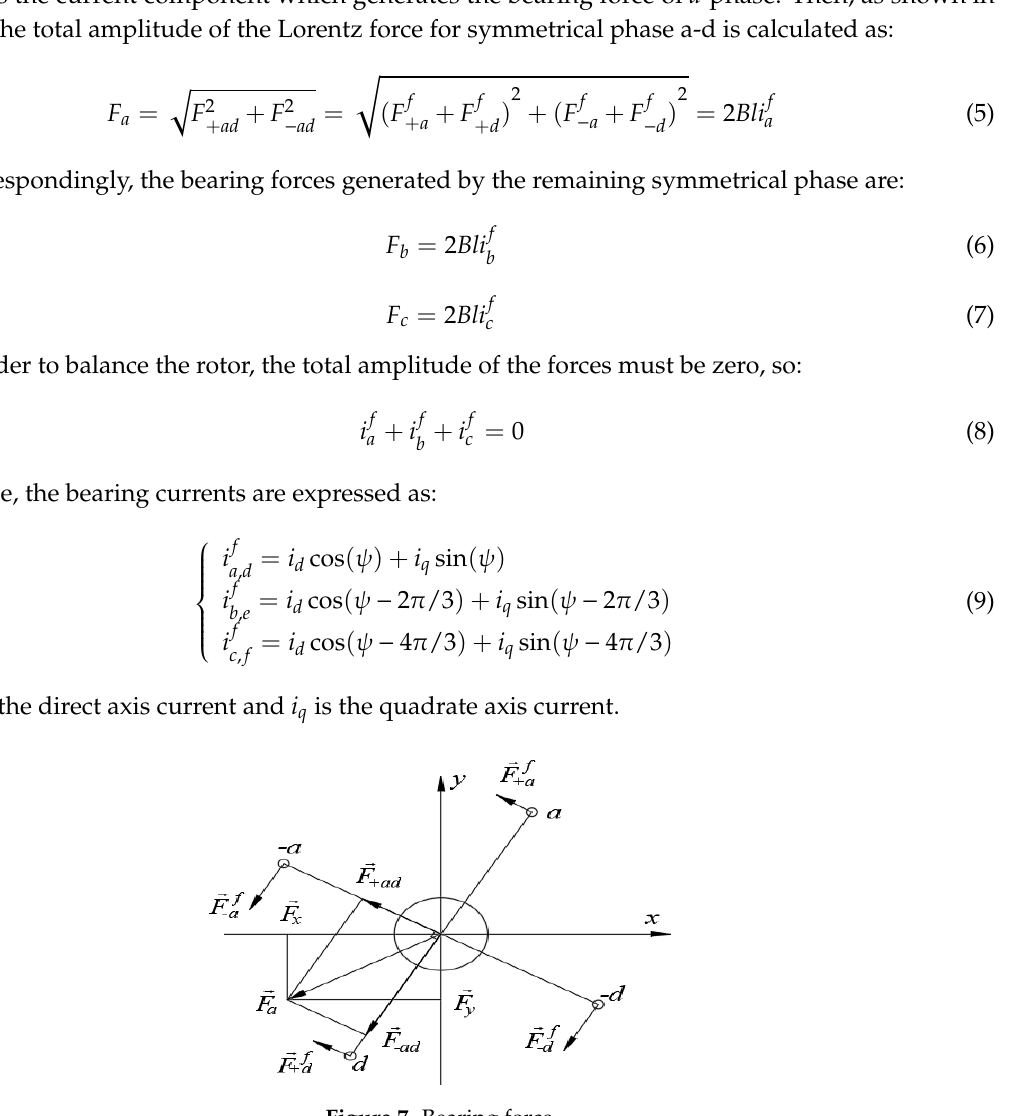
Figure 8. Motor torque.